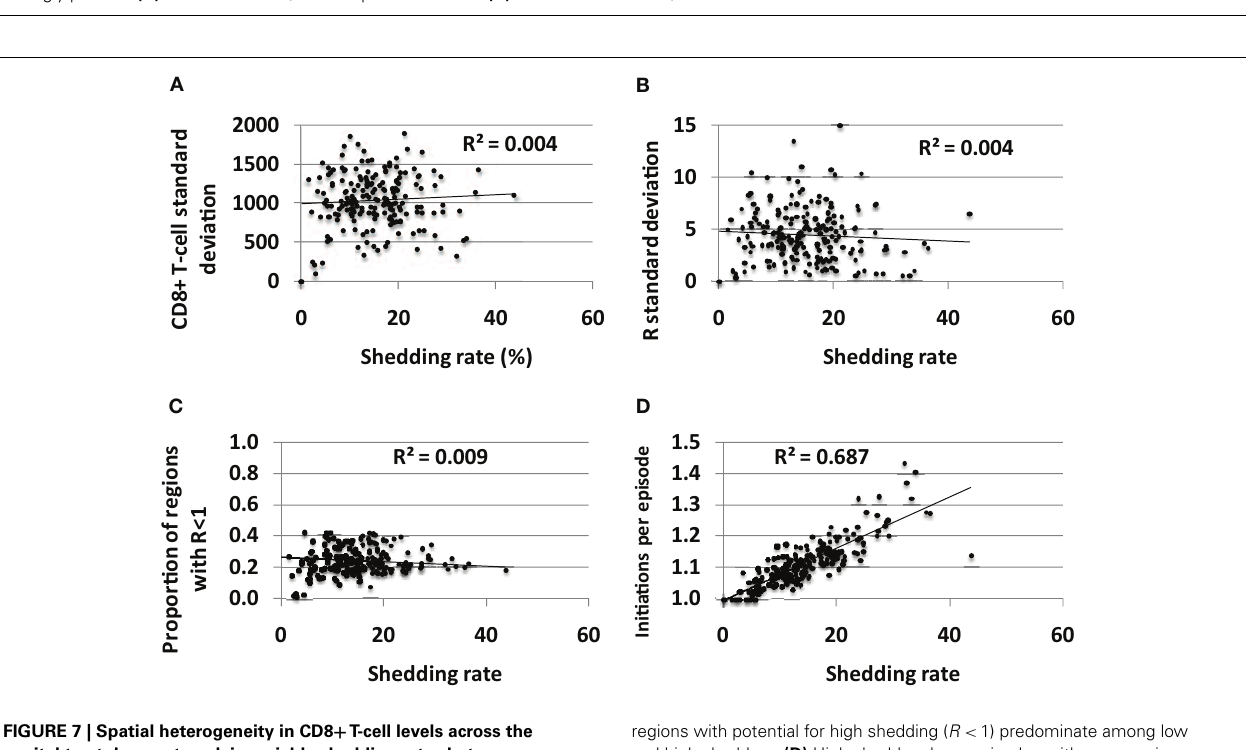
FIGURE 6 | High shedding rate predicts a highly dynamic immunologic state with more frequent CD8 + T-cell turnover . (A) Shedding rate predicts number of CD8 + T-cell births over 10years, and strongly predicts (B) number of CD8 + T-cell expansion events. (C) An